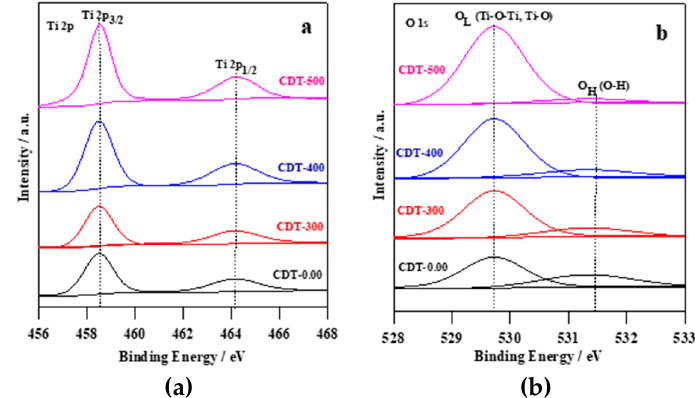
Figure 5. XPS detailed scans in the energy regions of: ( a ) Ti 2p; and ( b ) O 1s of all samples.